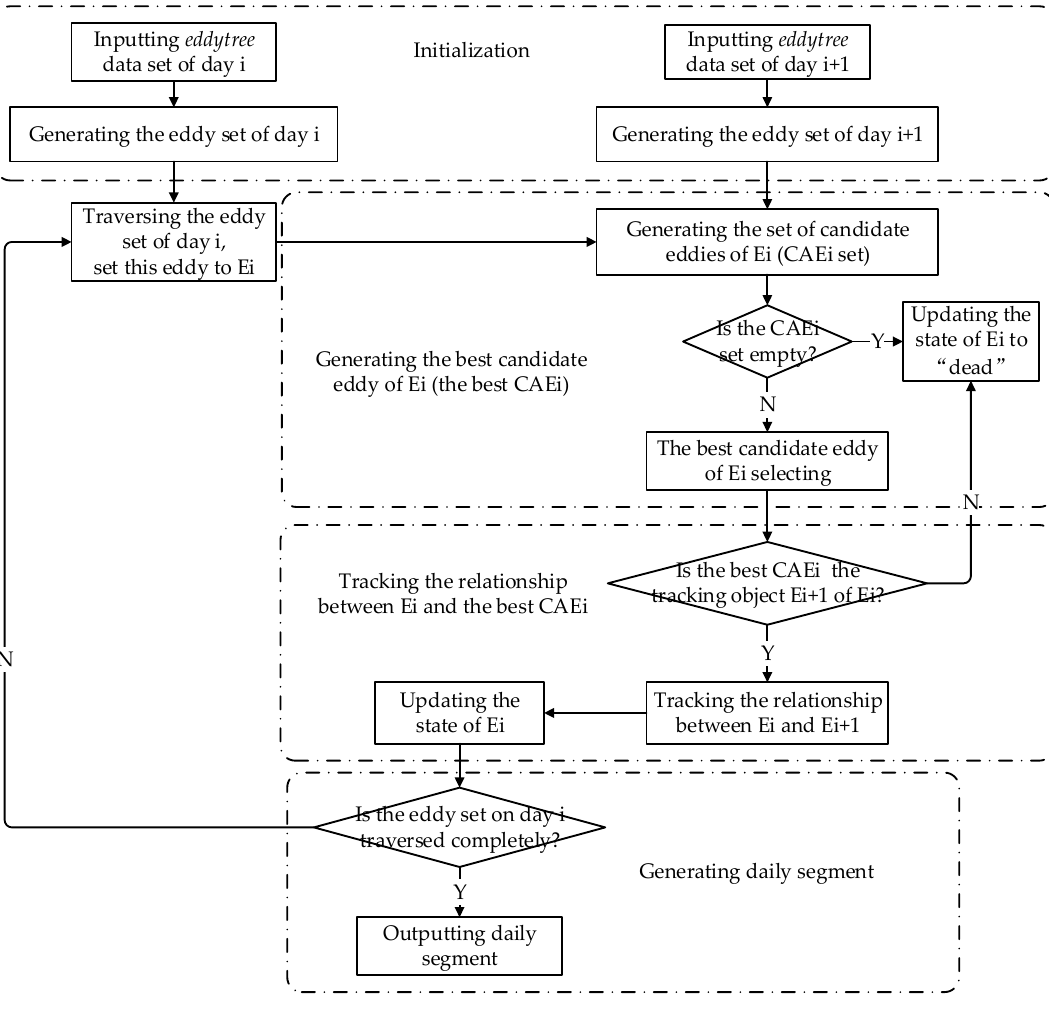
Figure 6. The workflow of tracking for a daily segment.